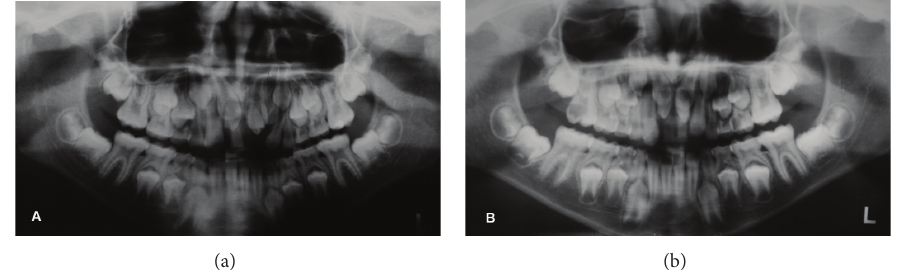
Figure 3: Panoramic radiograph showing impacted permanent maxillary central incisors and the presence of two mesiodens in both twins.